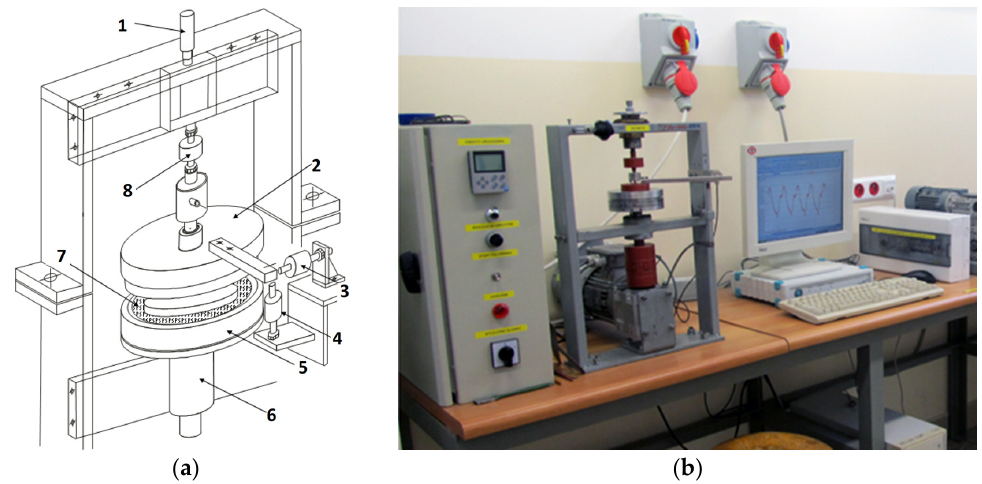
Figure 2. ( a ) Schematic representation of the annular powder rheometer: 1– shear plate positioner, 2—shear plate, 3—tangential load transducer, 4—displacement transducer, 5—rotating cell, 6—driving gear, 7—annular gap, 8—normal load transducer; ( b ) Picture of annular powder